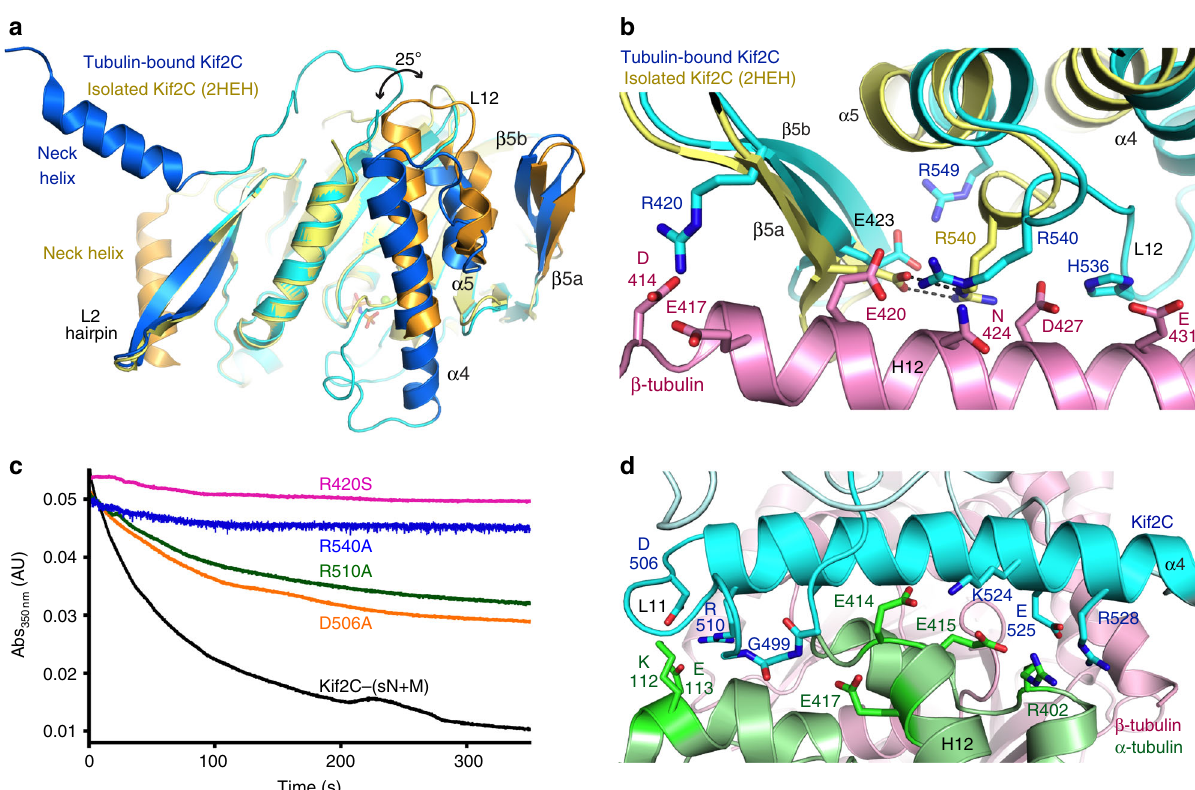
Fig. 3 The Kif2C conformational changes upon tubulin binding. a Structural changes of the Kif2C tubulin-binding subdomain upon tubulin binding. Kif2C in complex with tubulin is in cyan, with labeled secondary structural elements in blue (tubulin is not depicted). Isolated Kif2C (pdb id 2HEH) is in yellow with the secondary structural elements that change most upon tubulin binding in orange . A superposition taking the P-loop subdomain as a reference is presented as a Supplementary Fig. 3. b The restructuring of the β 5a – β 5b hairpin/ α 5 helix from isolated ADP-Kif2C (pdb id 2HEH, in yellow ) to tubulin- bound AMPPNP-Kif2C ( cyan ) places Kif2C Arg420, His536, and Arg540 close to acidic residues of the β -tubulin H12 helix. c Mutations of Kif2C residues at the interface with tubulin interfere with the depolymerization activity, as evaluated by a turbidity assay. Taxotere-stabilized microtubules (2 μ M) were incubated with 0.2 μ M R420S, D506A, R510A, or R540A mutants or with wild-type Kif2C-(sN+M), as indicated. See Supplementary Fig. 5 for additional characterization of the interaction of microtubules with R420S and R540A. d The Kif2C – tubulin interface centered on the α 4 helix. For clarity, the Kif2C α